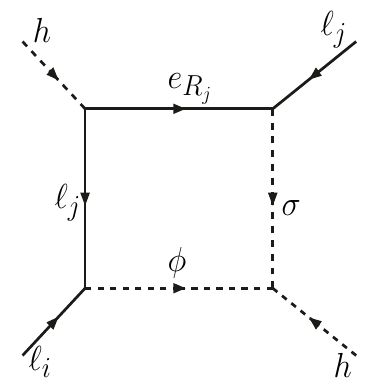
Figure 3 . Box diagram that generates Weinberg